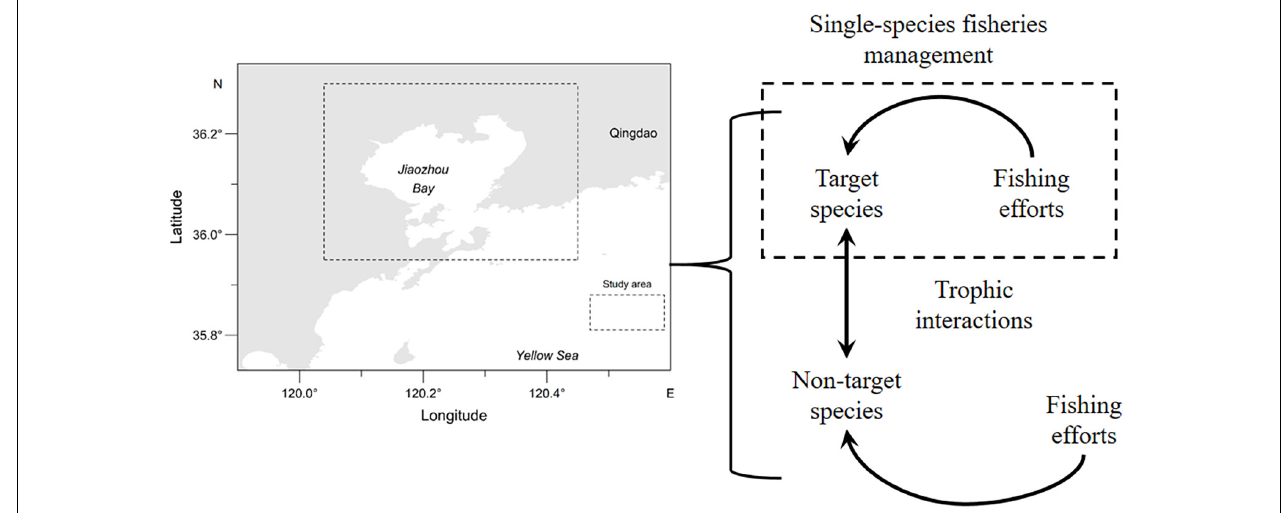
FIGURE 1 | Study area and SSFM in Jiaozhou Bay,